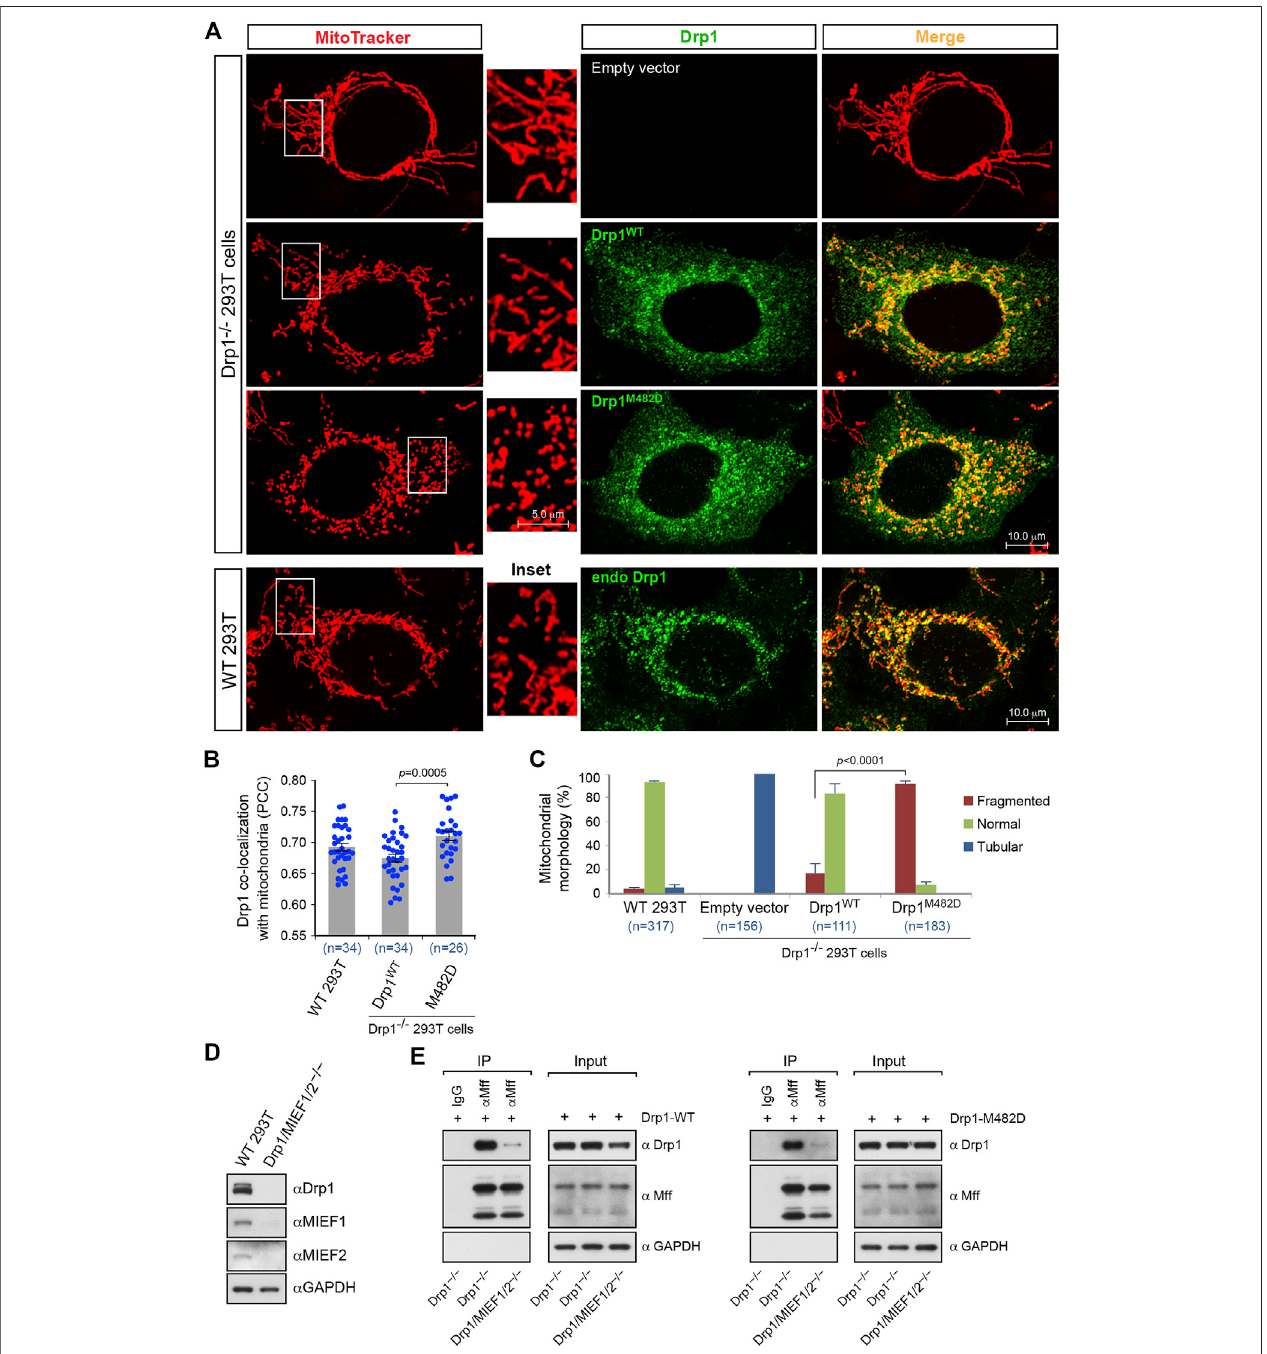
FIGURE 6 | The dominant oligomeric mutant Drp1-M482D is more competent in inducing mitochondrial fi ssion than Drp1-WT. (A) Confocal images of mitochondrial morphologyand Drp1 distribution inWT 293Tcellsand Drp1 − / − 293Tcells transfected withempty vector, Drp1-WTor Drp1-M482Dasindicated. At16 h post-transfection, cells were stained with MitoTracker (red) before fi xation, followed by immunostaining with anti-Drp1 antibody (green). Insets represent high magni fi cationviewsoftheboxedareas. (B) Quantitativeco-localizationofDrp1withmitochondriain(A)wasanalyzedbythe PCC (mean ± S.E.M.).nrepresentsthe number of cells analyzed. (C) Percentages (mean ± S.E.M.) of cells with indicated mitochondrial morphologies in WT 293T, Drp1 − / − 293T, and Drp1 − / − 293T cells transfected with Drp1-WT or Drp1-M482D as shown in (A) . n represents the number of cells analyzed. (D) The single cell derived colony of Drp1/MIEF1/2 − / − 293T cells wasvalidatedbyWestern blottinganalysiswithindicatedantibodies. WT293Tcellswereused ascontrol. (E) LossofMIEF1/2 severely reducedtheinteraction between endogenous Mff and exogenous Drp1-WT or Drp1-M482D. Cell lysates from Drp1 − / − or Drp1/MIEF1/2 − / − 293T cells transfected with Drp1-WT (left) or Drp1-M482D (right) wereusedforco-immunoprecipitation(IP)withProteinGbeadsconjugatedwithgoatnormalIgG(negativecontrol)orgoatanti-Mffantibody,followedbyWestern blotting with indicated antibodies.